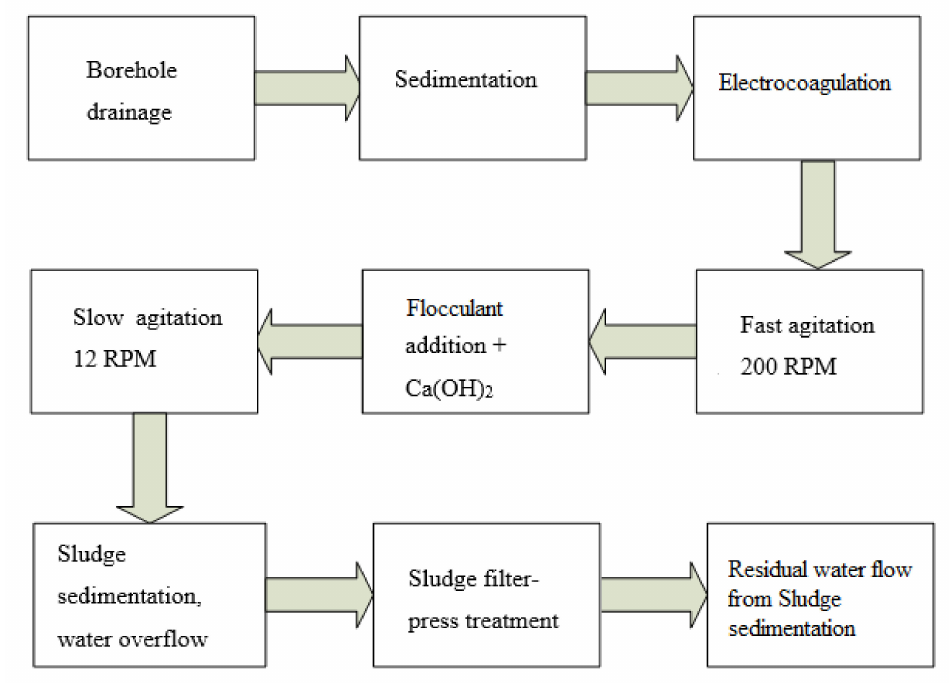
Figure 1. A simplified scheme of the process.